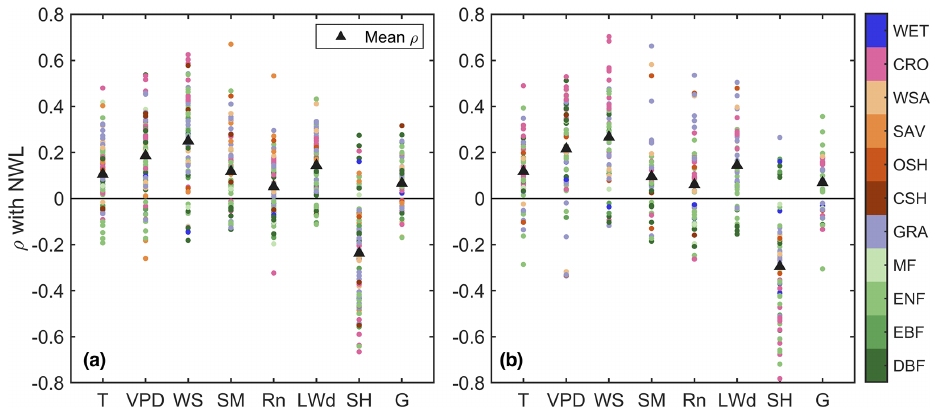
Figure 4. Spearman correlation ( ρ ) of 30min non-gap-filled nocturnal water loss (NWL) with air temperature ( T ), vapor pressure deficit (VPD), wind speed (WS), soil moisture (SM), net radiation (Rn), downward longwave radiation (LWd), sensible heat flux (SH), and ground heat flux ( G ) at the FLUXNET sites. Panel (a) is for all data and panel (b) is for summer months (JJA) at sites located above 30 ◦ N. Land cover types are deciduous broadleaf forest (DBF), evergreen needleleaf forest (ENF), evergreen broadleaf forest (EBF), mixed forest (MF), grassland (GRA), closed shrubland (CSH), open shrubland (OSH), savanna (SAV), woody savanna (WSA), cropland (CRO), and wetland (WET).